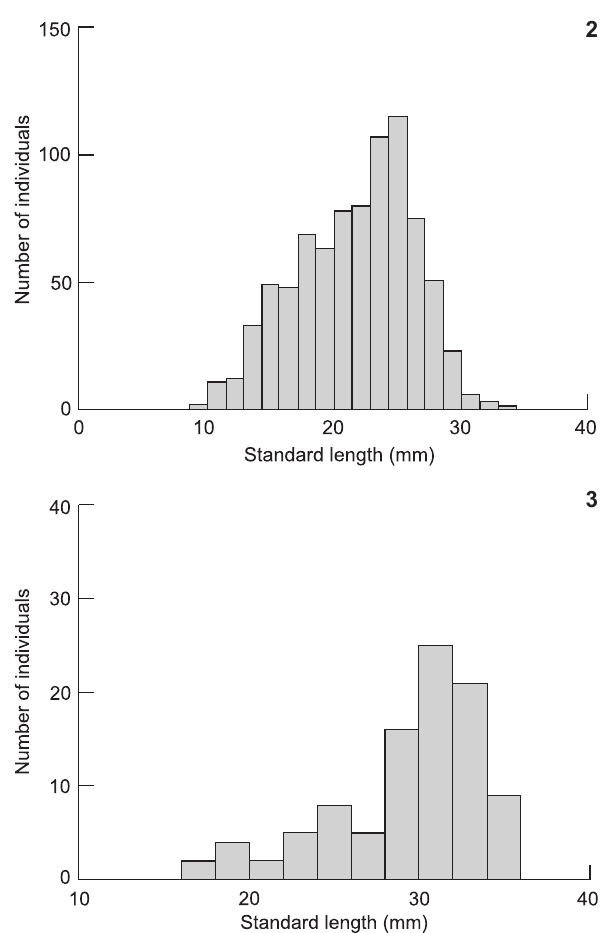
Figures 2-3. Length-frequency distributions of H. marginatus caught in the Piravevê sub-basin (2) and Vitoria (3), Ivinhema River